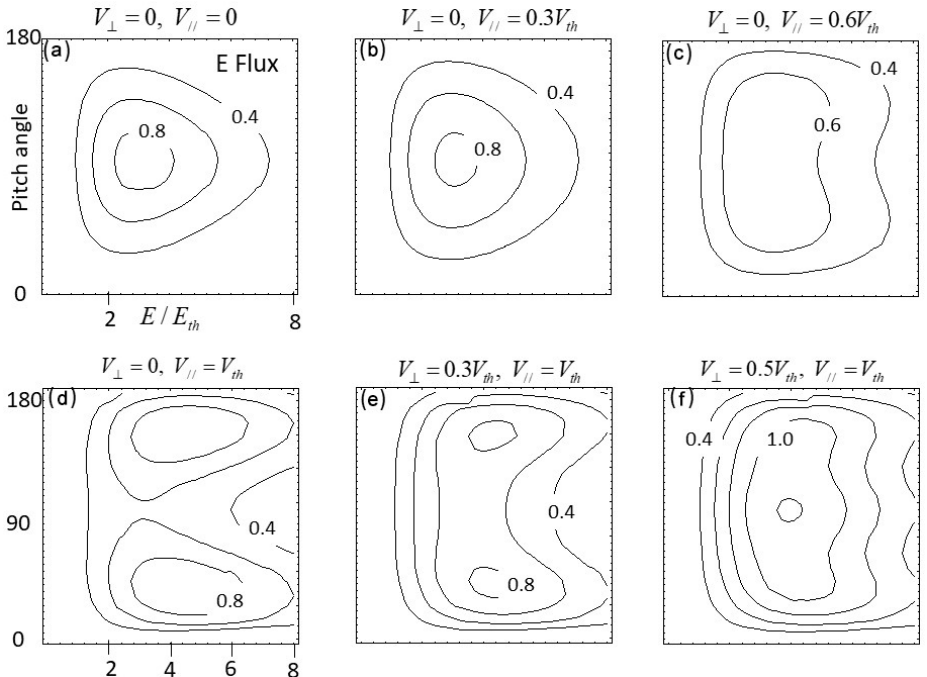
Figure 3. Simulated pitch angle spectrogram of energy flux for drift Maxwell distributions of phase space density. Energy flux was shown in contour plots with arbitrary amplitudes. To show how the pitch angle spectrogram evolves, drift velocities in parallel and perpendicular directions with respect to the background magnetic fields have changed. No drifts in both perpendicular and parallel to the background field lines (a) . Only parallel drifts increased: 0.3 (b) , 0.6 (c) and 1.0 V th (d) . For (e) and (f) , perpendicular drift increased to 0.3 and 0.5 V th while parallel drift remained at 1.0 V th . V th denotes thermal velocity. The vertical axis is for pitch angles, while the horizontal axis is for particle energies normalized by the thermal